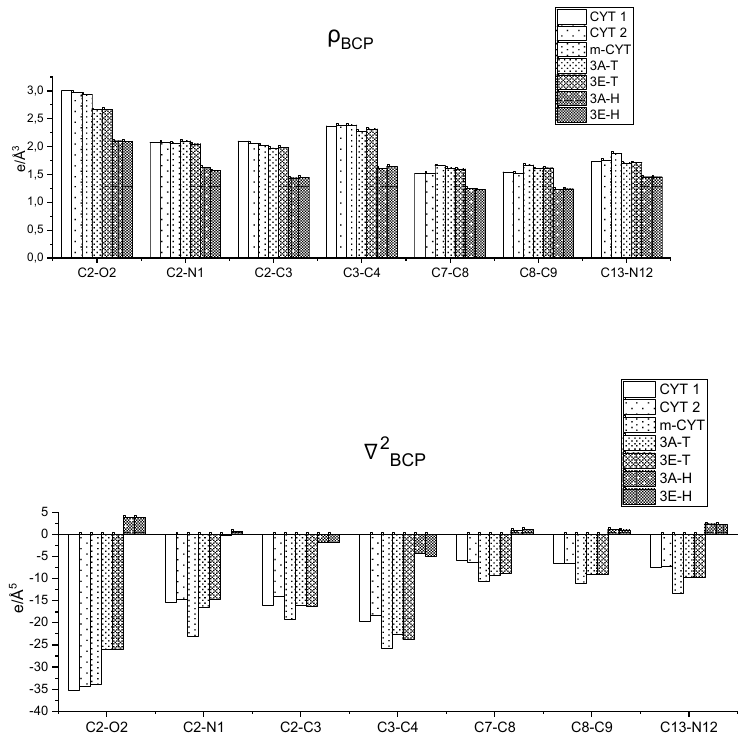
Figure 5. A comparison of the values of electron density at bond critical point (top) and Laplacian (bottom) at this point. The codes are: CYT1, CYT2–two symmetry independent molecules of (-)cytisine [19], m-CYT— N -methylcytisine [19], 3A-T, 3E-T: molecules 3A and 3E with transferred multipolar coefficients; 3A–H, 3E–H: 3A and 3E at IAM level with H atoms moved to neutron posi-